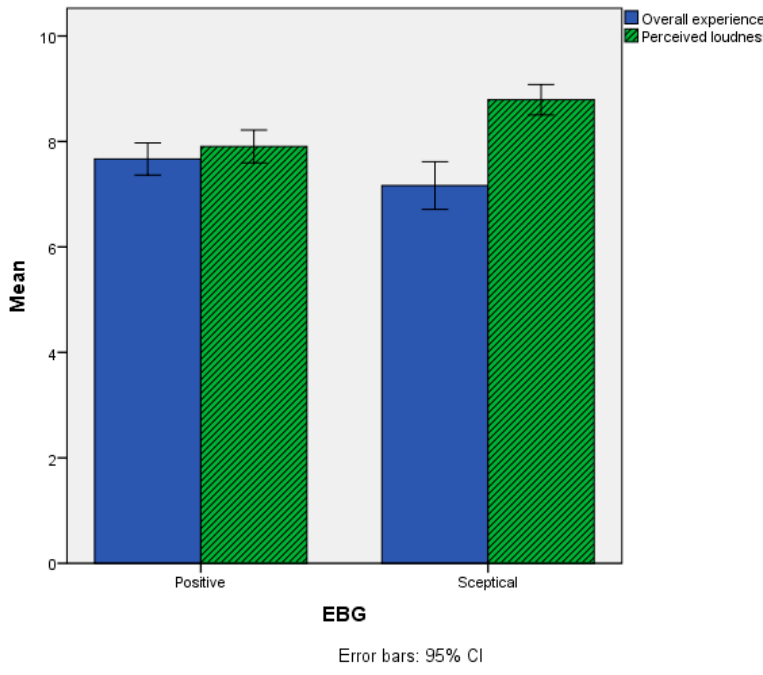
Figure 10. Mean scores of the Perceived loudness and Overall experience items as a function of the EBG variable. Grey-shaded bars refer to items where statistically significant differences were observed between the two groups. Table 5. Independent-samples t -tests for the Soundscape appraisal, Perceived loudness and Overall experience items between the EBG groups. EBG: Expected Benefit of Greenery.